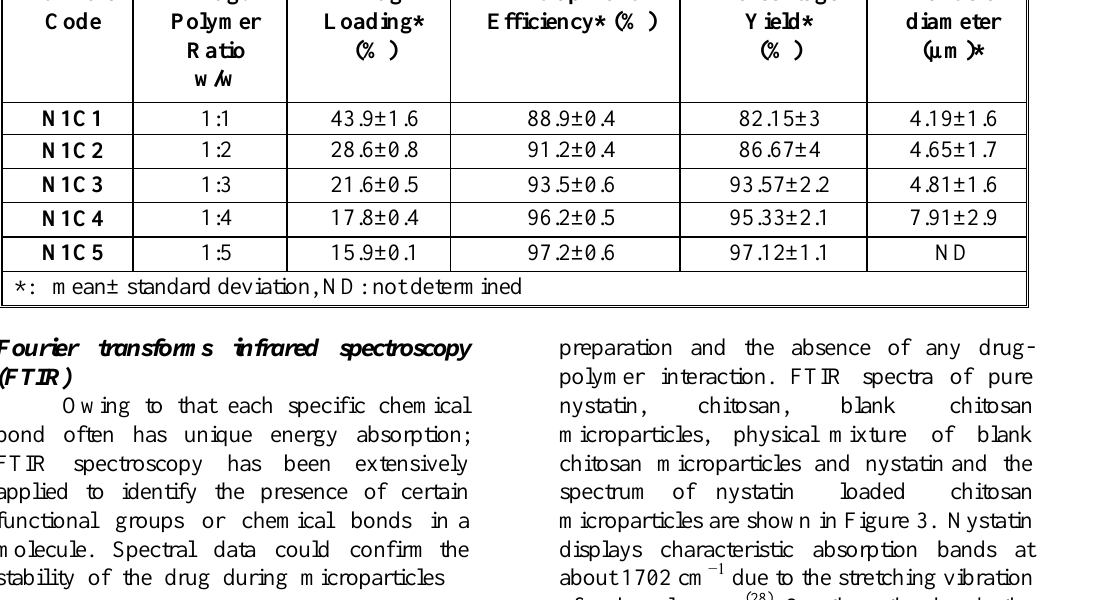
Table ( 2): Drug Loading (%), Entrapment Efficiency (%), Yield (%) and Particle Diameter of Nystatin- Loaded Microparticles Formulas.